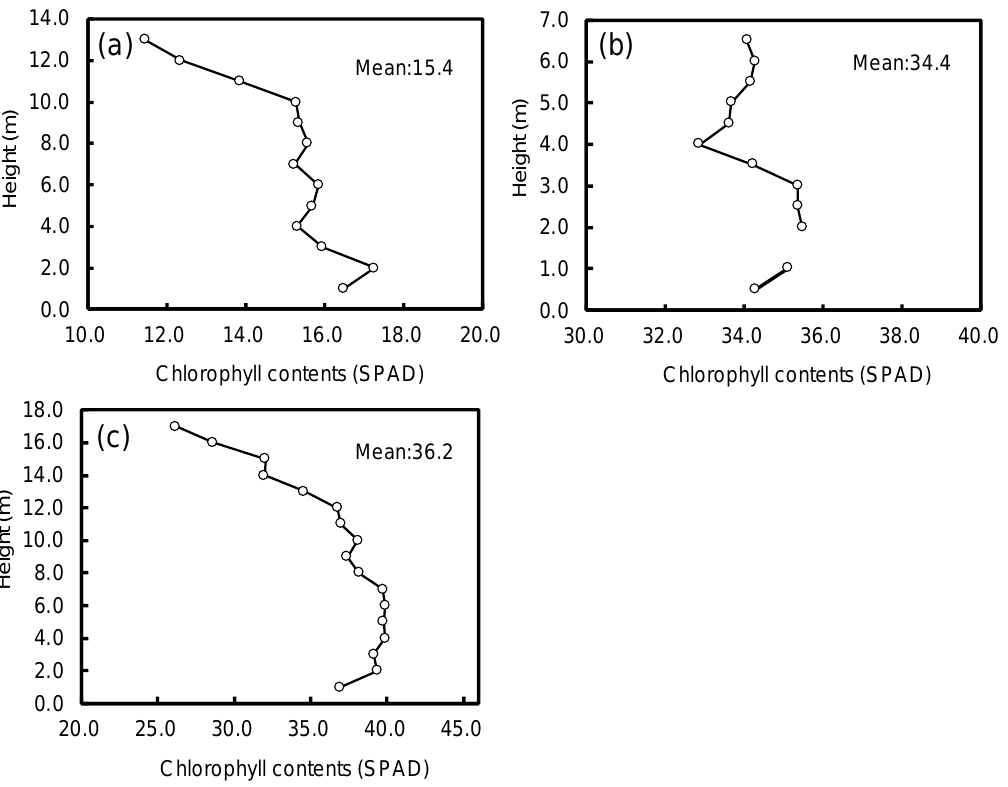
Figure 5. Vertical distributions of chlorophyll (Chl) contents for each sample. (a) Sample A, (b) Sample B, and (c) Sample C. The absence of a line in the profile between 1.0 to 2.0 m height for sample B means that there were no leaves at the height of 1.5 m.